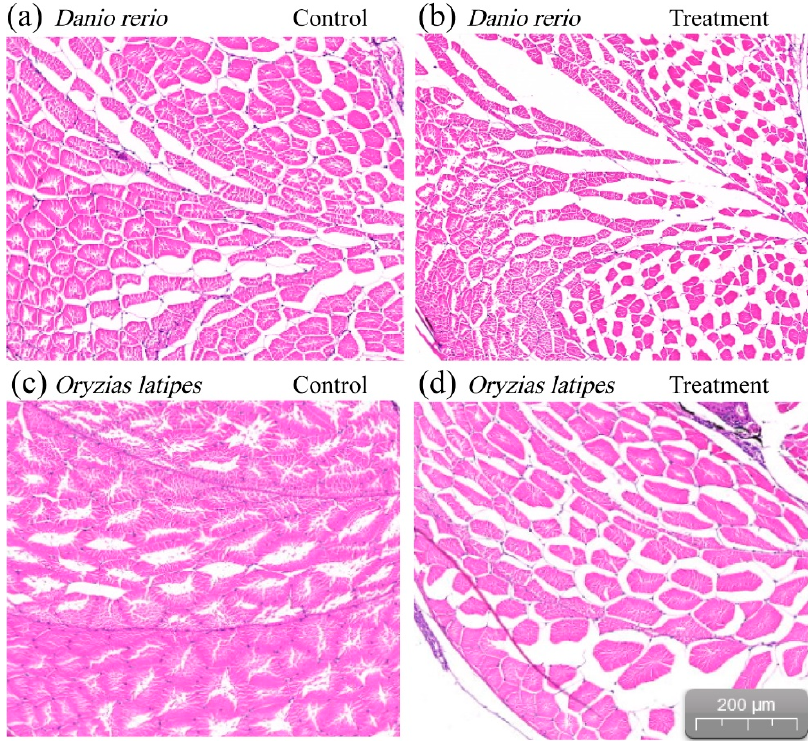
Figure 3. Thinner and weaker muscle fibers bundles exposed to 2 mg/L. ( a ) and ( b ) of D. rerio ; ( c ) and ( d ) of O. latipes.